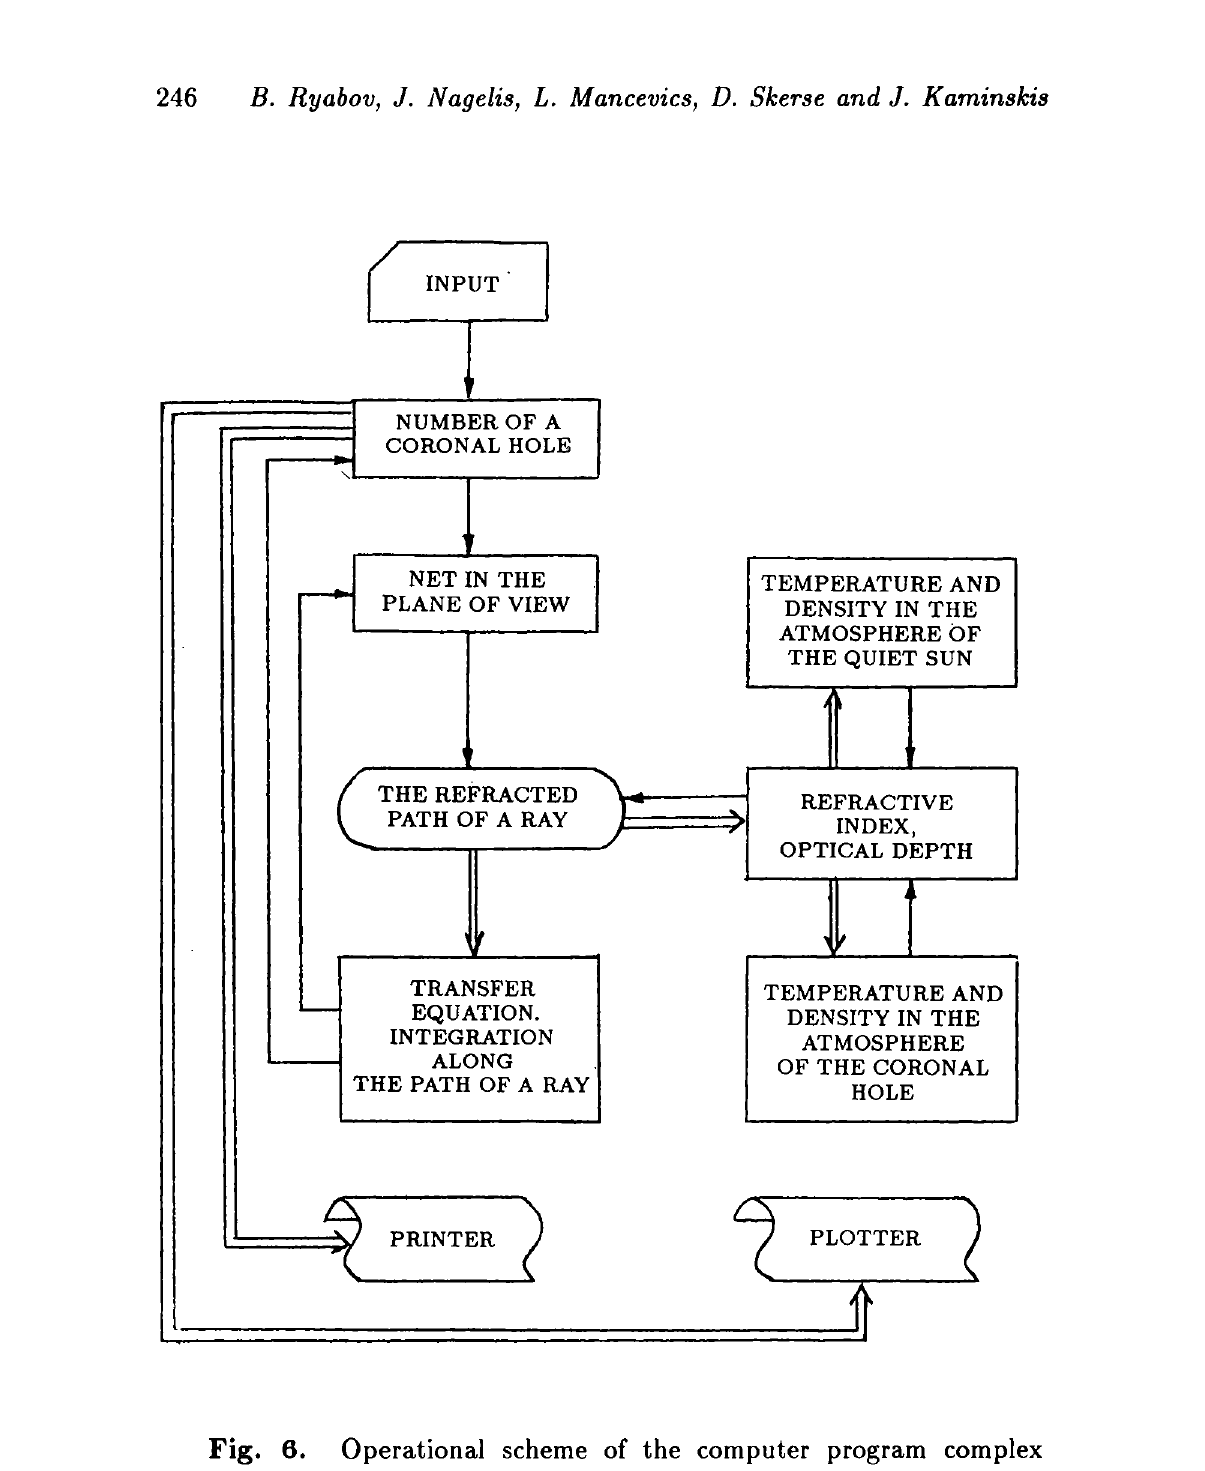
Fig. 6. Operational scheme of the computer program complex